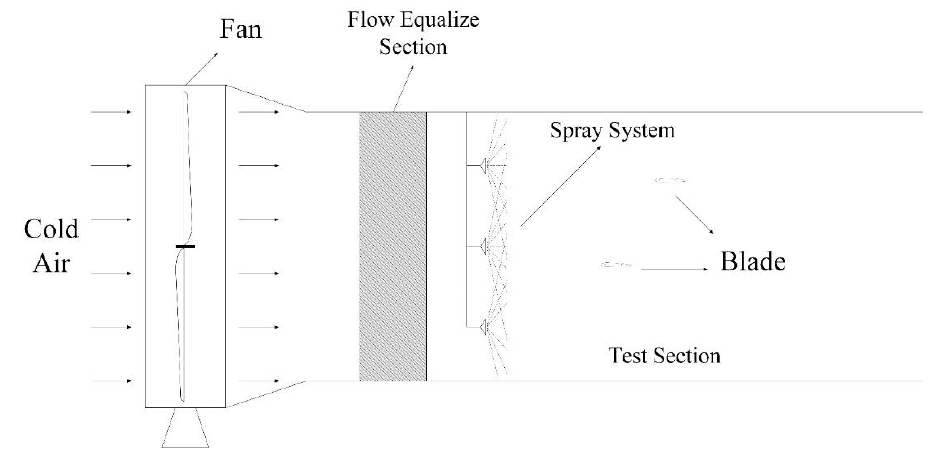
Figure 2. Schematic of the test wind tunnel.